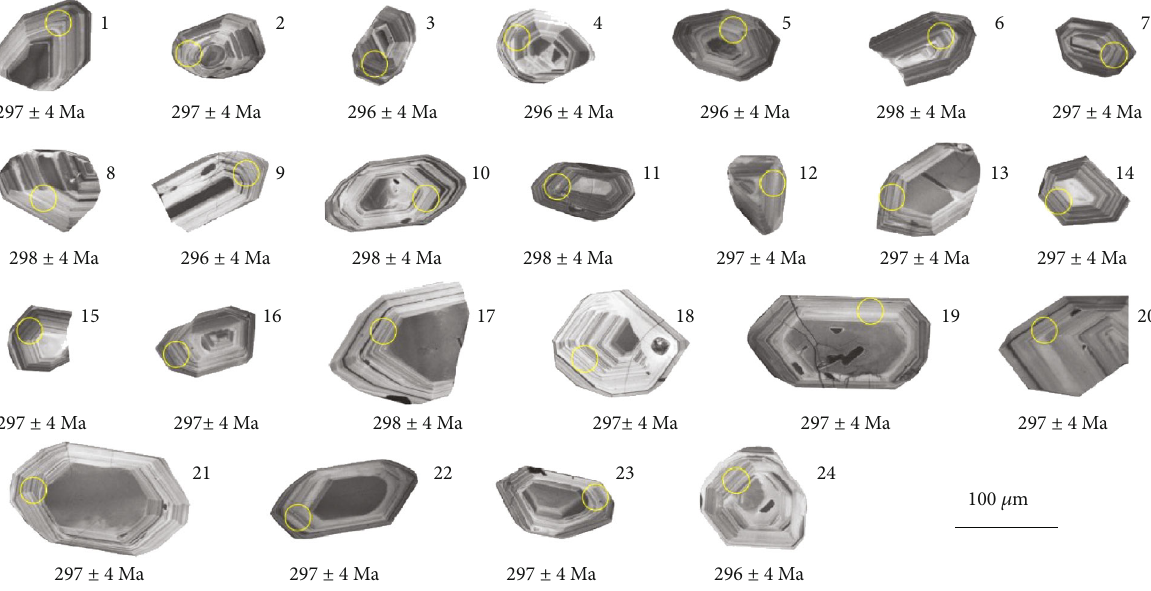
Figure 6: Cathodoluminescence (CL) images of representative zircons from granite porphyry in the Tieling deposit.